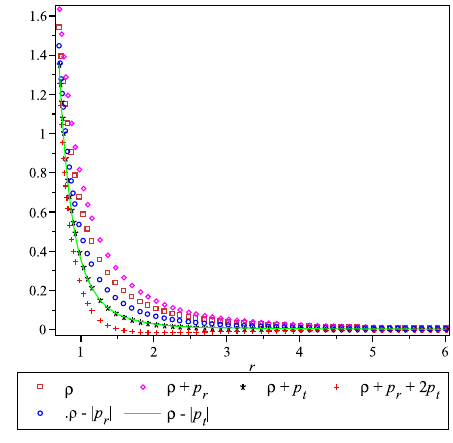
( a ) This figure depicts the behavior of all EC terms for Model-II in Subcase 3 ( ξ 2 = 0, α 2 < 0, α > 0). All ECs are shown to satisfy for r > 1 . 5.